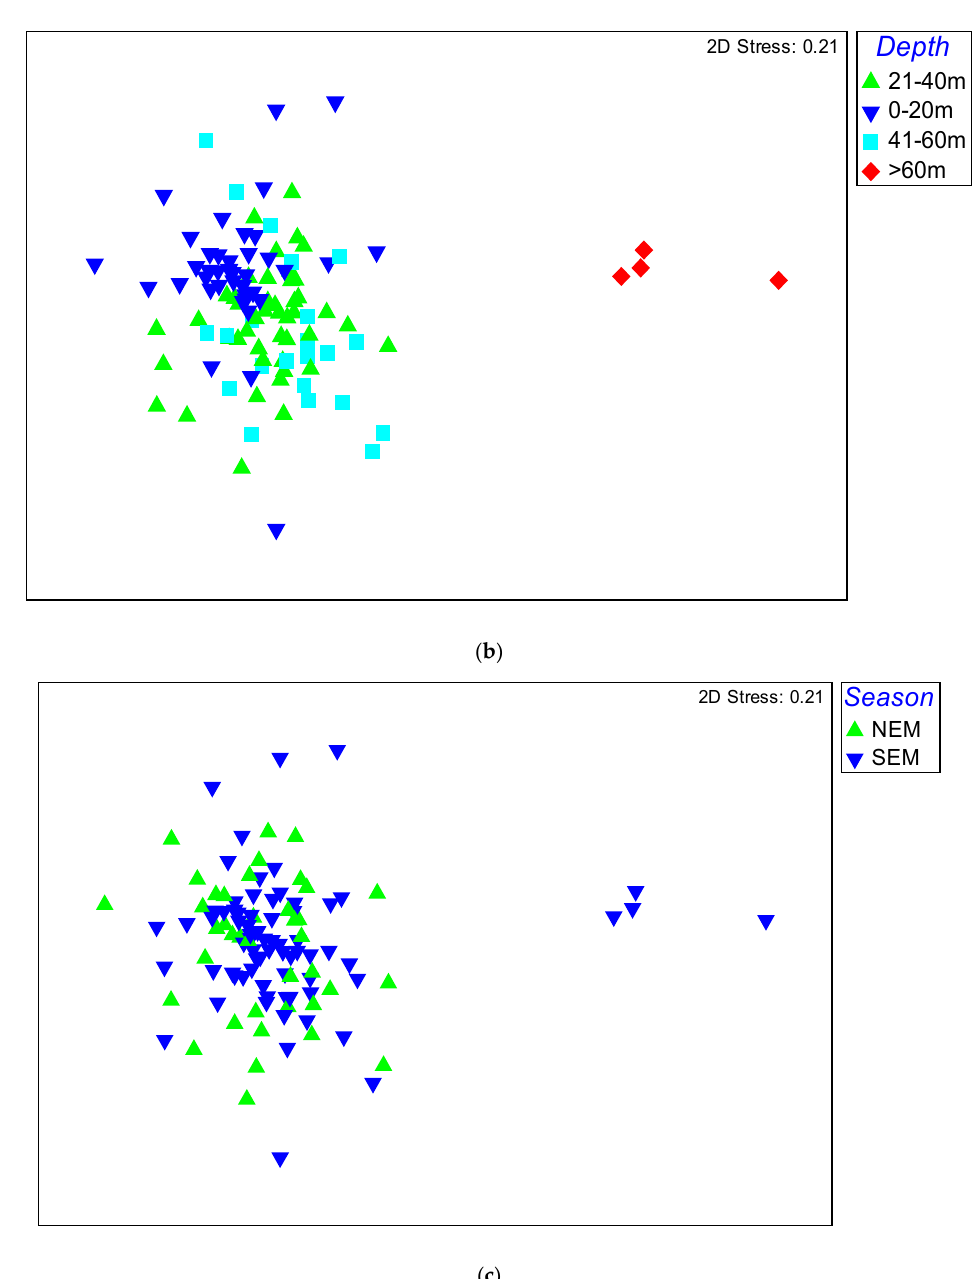
Figure 3. Bray–Curtis similarity plots of species composition between the ( a ) sites, ( b ) depth, and ( c ) seasons.